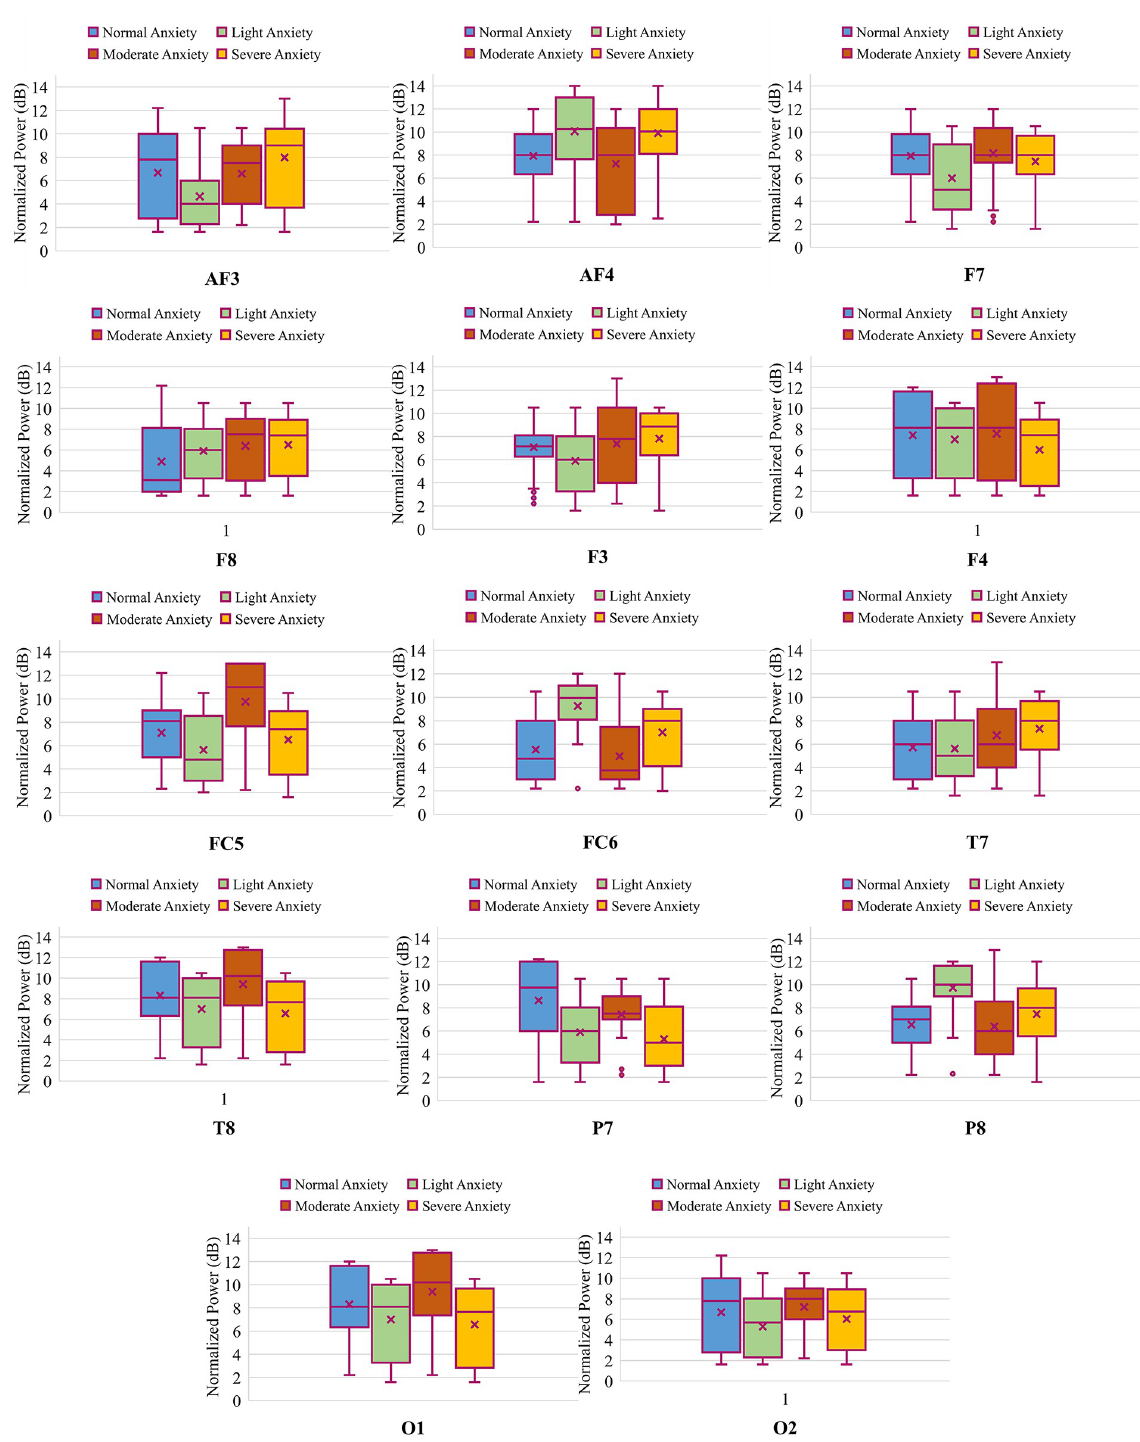
Fig 6. Box-and-whisker diagram of the power obtained from each channel of the Emotiv EPOC headset for four level anxiety classification.